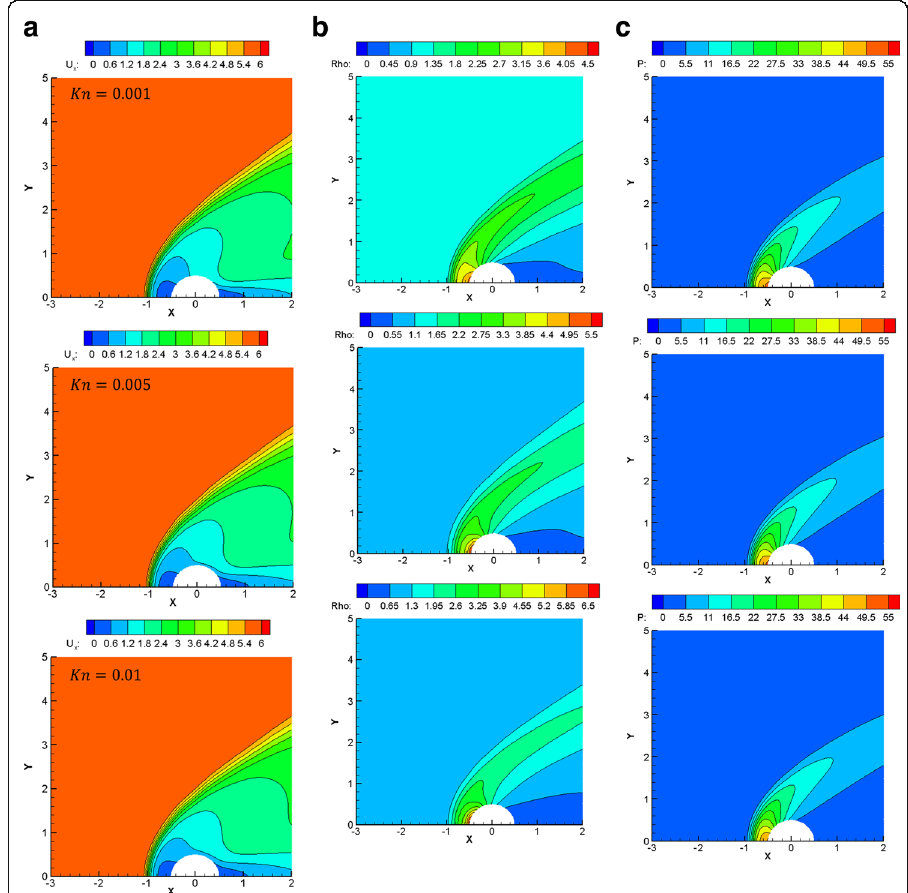
Fig. 15 Contour plots of normalized conserved variables for different Knudsen numbers (0.001, 0.005, and 0.01), plotted in rows, at M = 6: a U x velocity, b density, and c